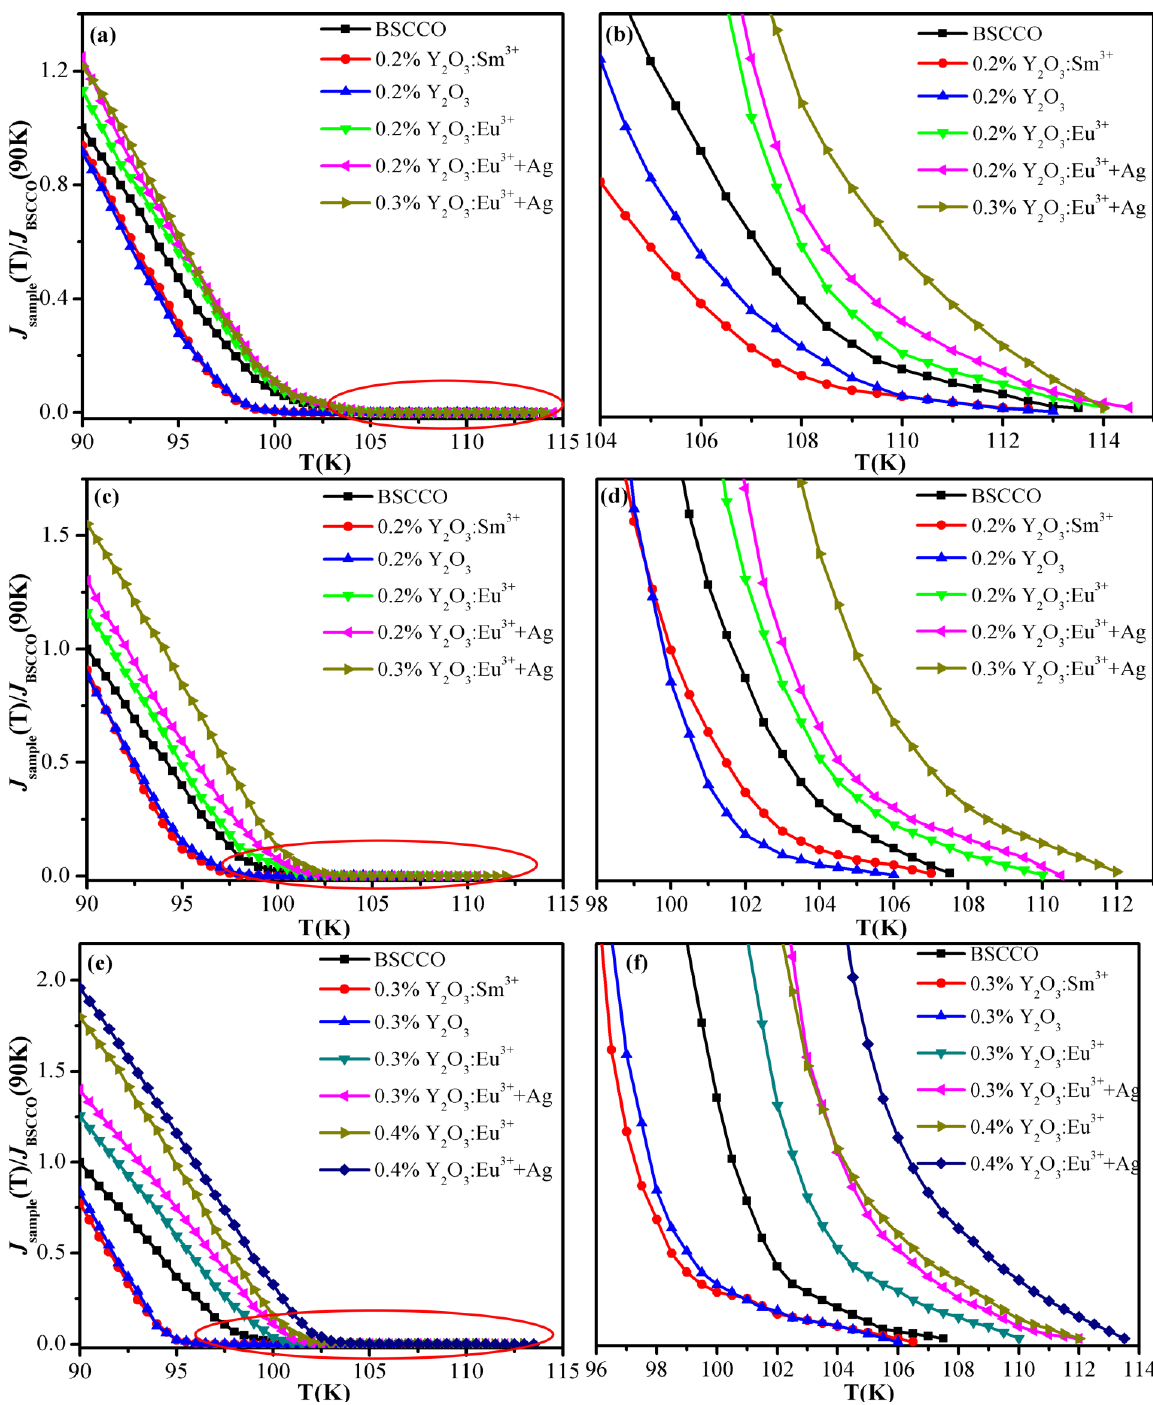
Figure 3. The relationship between J C and temperature of pure B(P)SCCO and doping B(P)SCCO samples. ( a , b ) The relationship between J C and temperature of pure B(P)SCCO (A1) and B(P)SCCO doped with 0.2 wt% Y 2 O 3 :Sm 3+ (A2), Y 2 O 3 (A3), Y 2 O 3 :Eu 3+ (A4), Y 2 O 3 :Eu 3+ +Ag (A5), and 0.3 wt% Y 2 O 3 :Eu 3+ +Ag (A6). ( c , d ) The relationship between J C and temperature of pure B(P)SCCO (B1) and 0.2 wt% Y 2 O 3 :Sm 3+ (B2), Y 2 O 3 (B3), Y 2 O 3 :Eu 3+ (B4), Y 2 O 3 :Eu 3+ +Ag (B5), and 0.3 wt% Y 2 O 3 :Eu 3+ +Ag (B6) doped samples. ( e , f ) The relationship between J C and temperature of pure B(P)SCCO (C1) and B(P)SCCO doped with 0.3 wt% Y 2 O 3 :Sm 3+ (C2), Y 2 O 3 (C3), Y 2 O 3 :Eu 3+ (C4), Y 2 O 3 :Eu 3+ +Ag (C5), 0.4 wt% Y 2 O 3 :Eu 3+ (C6), and 0.4 wt% Y 2 O 3 :Eu 3+ +Ag (C7). ( b , d , f ) are partial enlarged